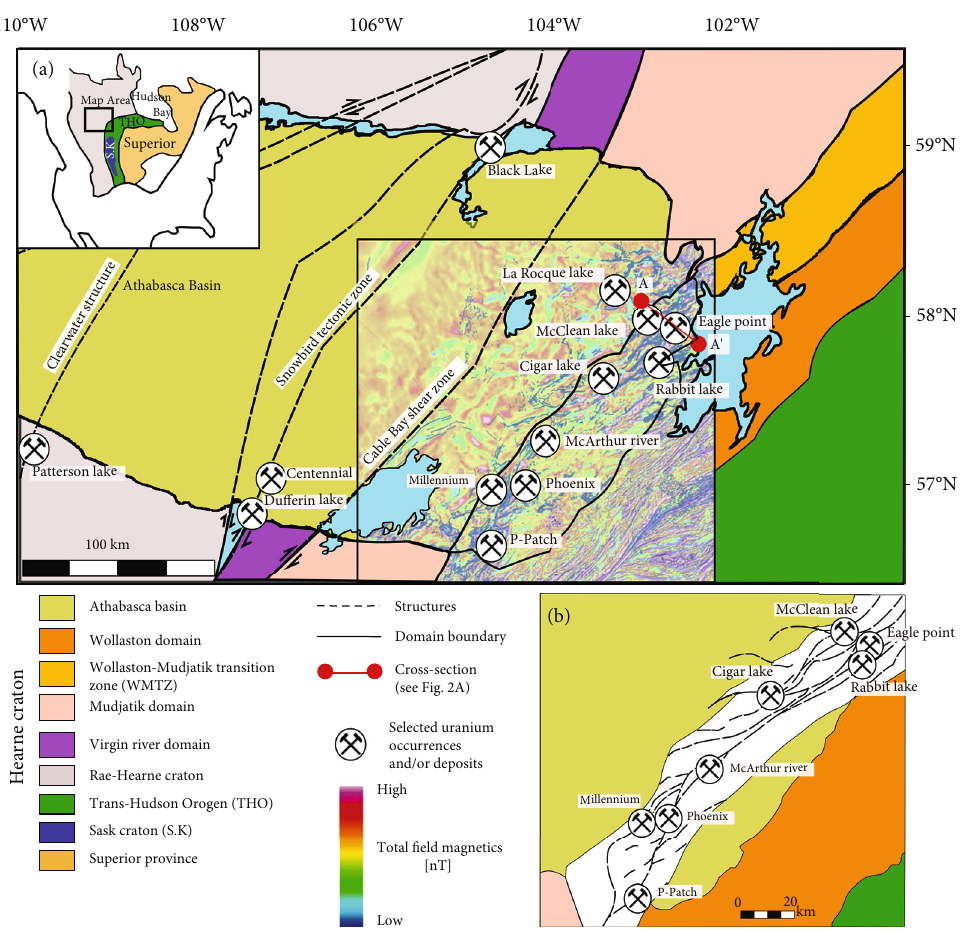
Figure 1: (a) Generalised tectonic map of the Rae-Hearne craton, Western Canadian shield, with named unconformity-related uranium deposits and main structural features that has been modi fi ed from Annesley et al. [14], Alexandre et al. [28], and Eglington et al. [107]. A composite interpreted aeromagnetic map (provided by Orano Canada Inc) is superimposed on the map as an inset for (a), highlighting the di ff erent structural types located in the Mudjatik Domain and Wollaston-Mudjatik Transition Zone. (b) Interpreted structural features of the basement along the Wollaston-Mudjatik Transition Zone with named unconformity-related uranium deposits and occurrences (modi fi ed from [16, 24]). Dashed lines indicated main structural features. The solid red line (A-A ’ ) within inset represents a schematic cross-section of the Wollaston-Mudjatik Transition Zone in Figure